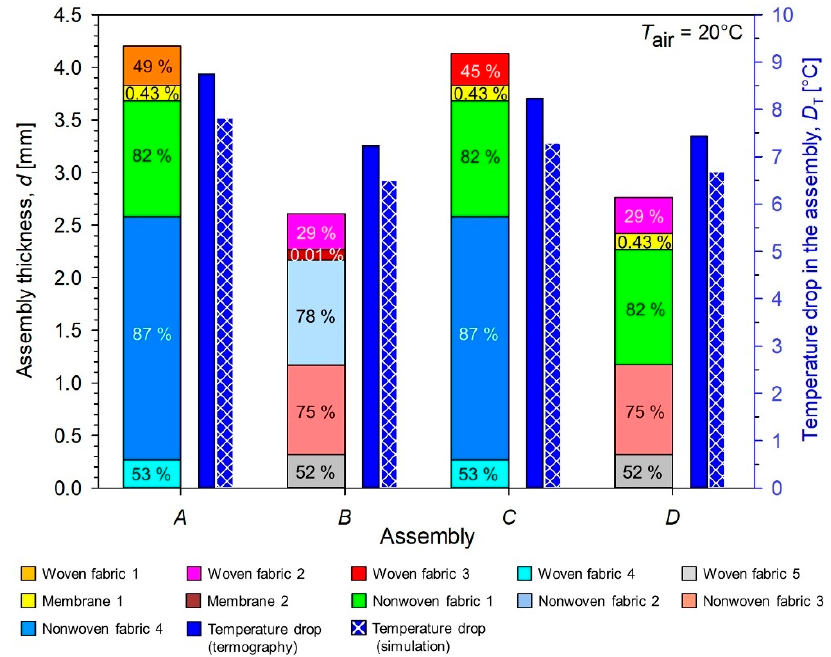
Figure 12. Influence thickness d and porosity p (presented inside wide bars) of assembly layers on experimental (blue plain bar) and simulated (blue checked bar) drop temperature D T in the assembly for air temperature T air = 20 °C.